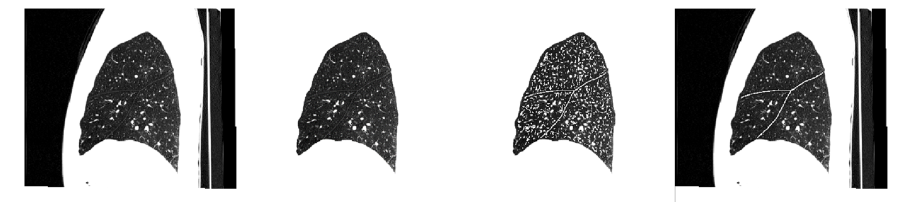
Figure 3. Illustration of fissure segmentation.